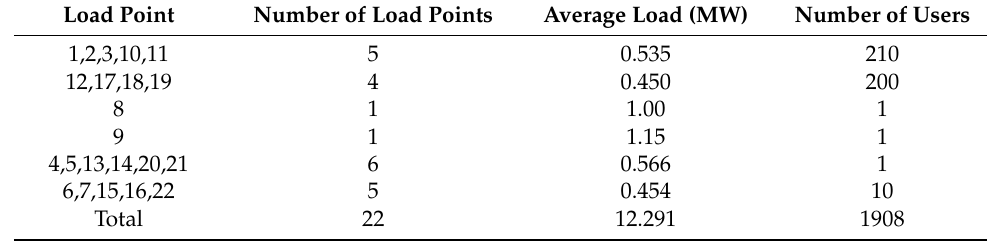
Table A3. Load point user type and peak load.